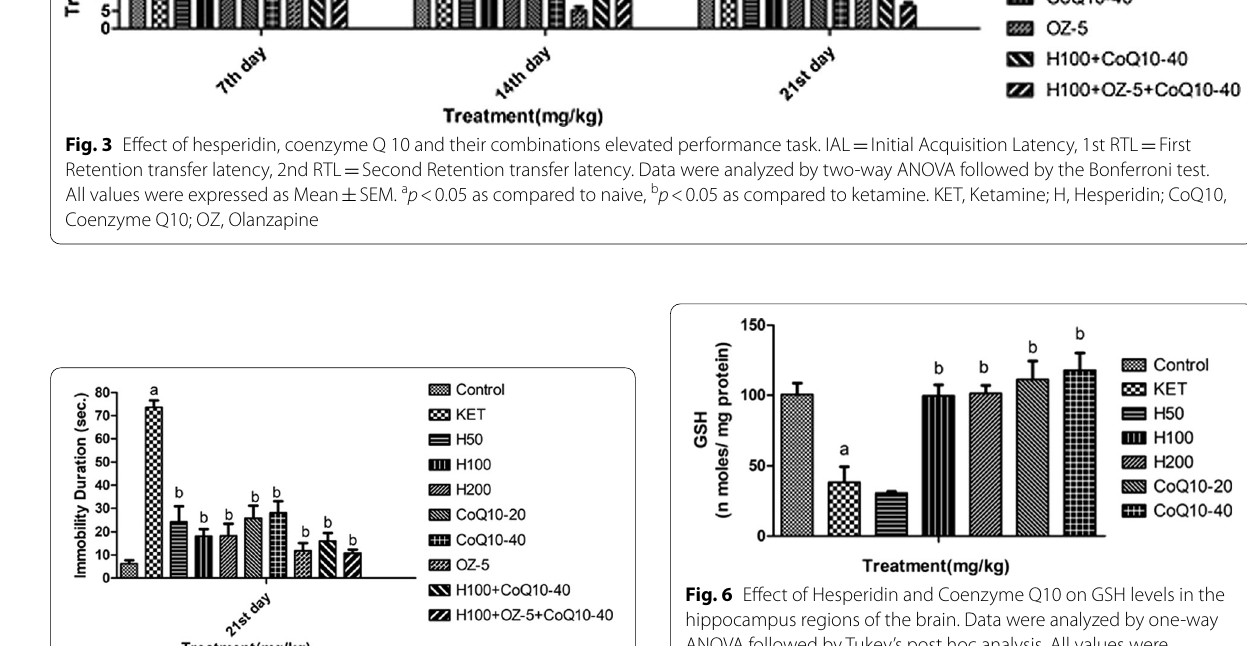
Fig. 4 Effect of Hesperidin, Coenzyme Q10 and their combinations on immobility time. Data were analyzed by two-way ANOVA followed by the Bonferroni test. All values were expressed as Mean a p < 0.05 as compared to naive, b p < 0.05 as compared to ketamine. KET, Ketamine; H, Hesperidin; CoQ10, Coenzyme Q10; OZ, Olanzapine